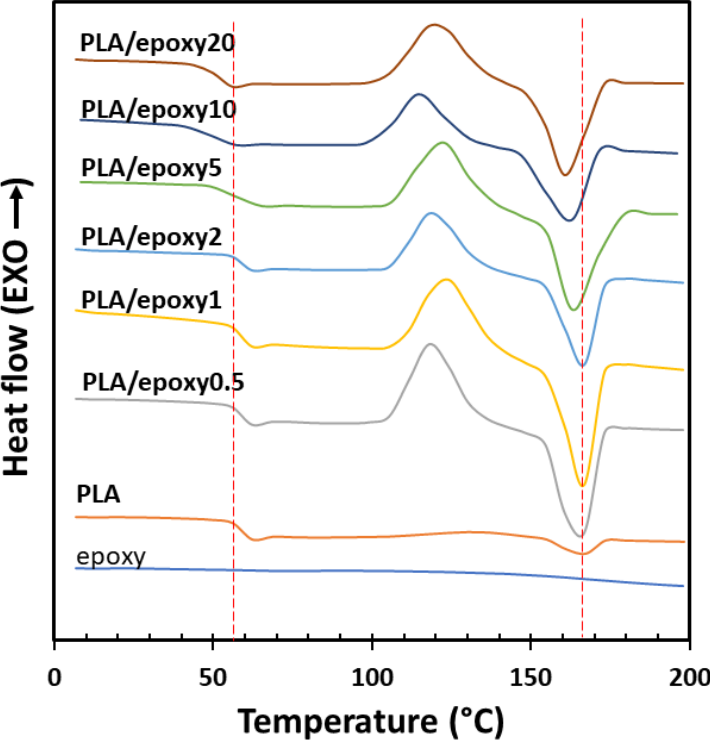
Figure 3. The second scan DSC curves of epoxy, PLA, and the PLA blend with 0.5–20%